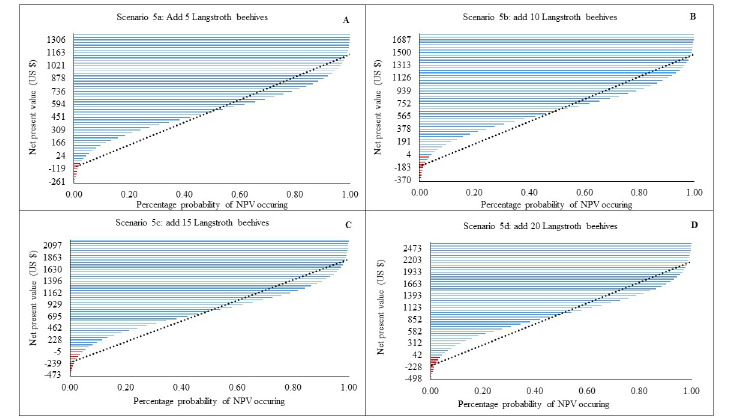
Fig 6. Modelled probability (%) changes in Net Present Value (NPV) for Langstroth numbers (scenarios 5a-d). Income changes following addition of frame hives (Langstroth and related hives). Red lines indicate loss and blue lines profit. Dotted black line is a linear forecast. NPVs to the right of the line indicate optimal profit/loss attained for each an intervention